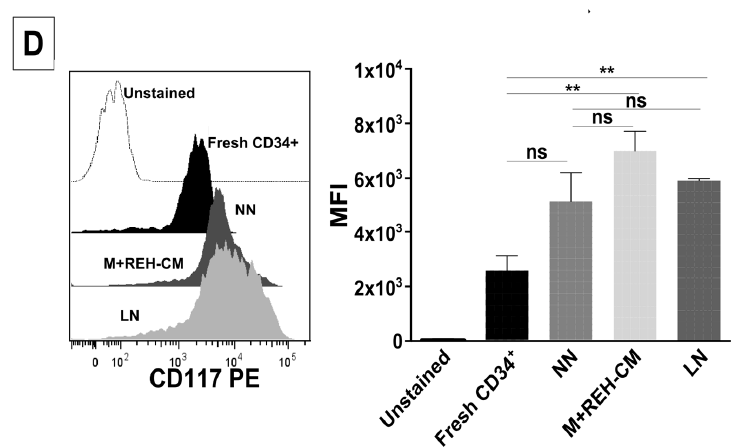
Figure 4. Changes in stem cell and differentiation markers of CD34 + cells in the LN . Flow cytometry analysis of ( A ) CD34, ( B ) CD133, ( C ) CD38, and ( D ) CD117 (c-Kit) expression in freshly-isolated, NN, M + REH-CM, and LN CD34 + cells. Results are expressed as the median fluorescence intensity (MFI) obtained from two independent experiments done in triplicates ( n = 6) (ns: non-significant, * p < 0.05, ** p < 0.01).